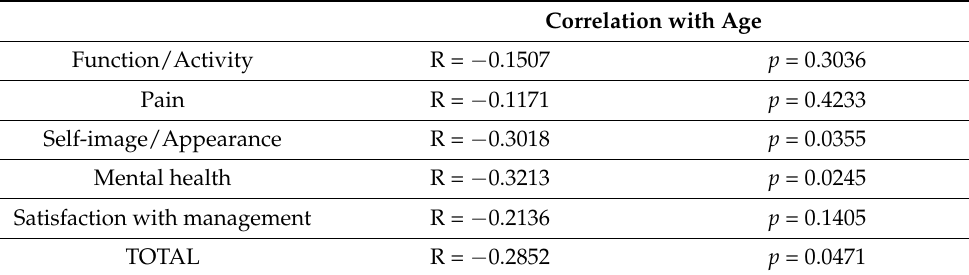
Table 5. Correlations between patient’s age, total SRS-30 score, and its